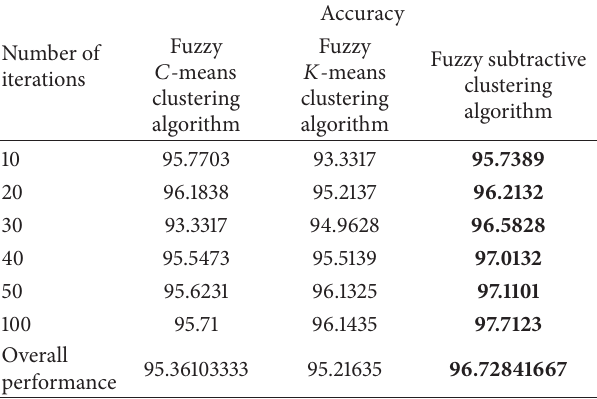
Table 2: Accuracy of the three fuzzy clustering algorithms for data